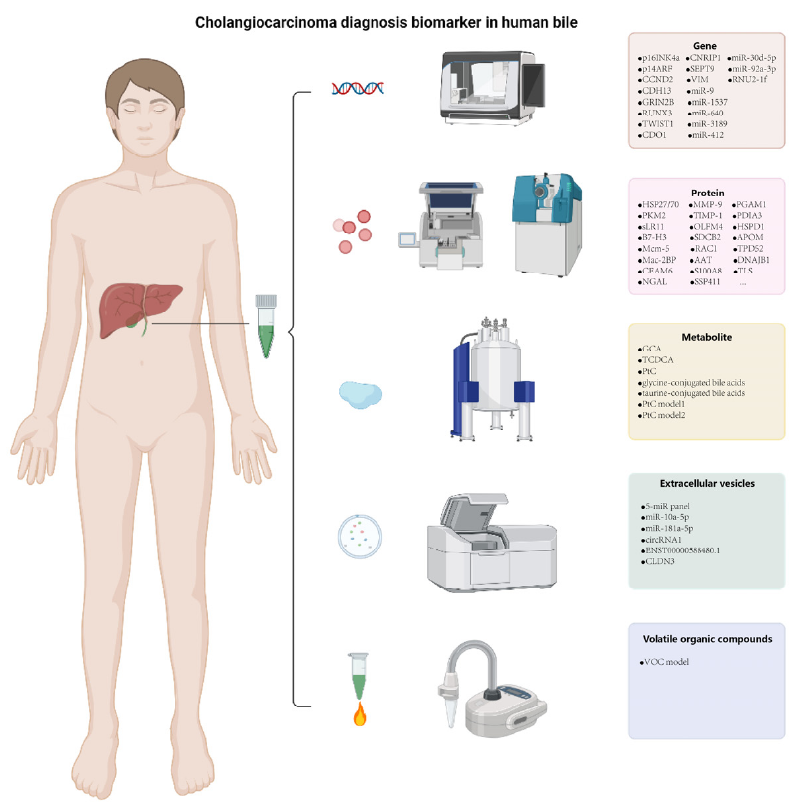
Figure 1. Cholangiocarcinoma diagnosis biomarker in human bile. Classification and identification methods of diagnostic biomarkers for cholangiocarcinoma in human bile. Created with bioren- der.com.